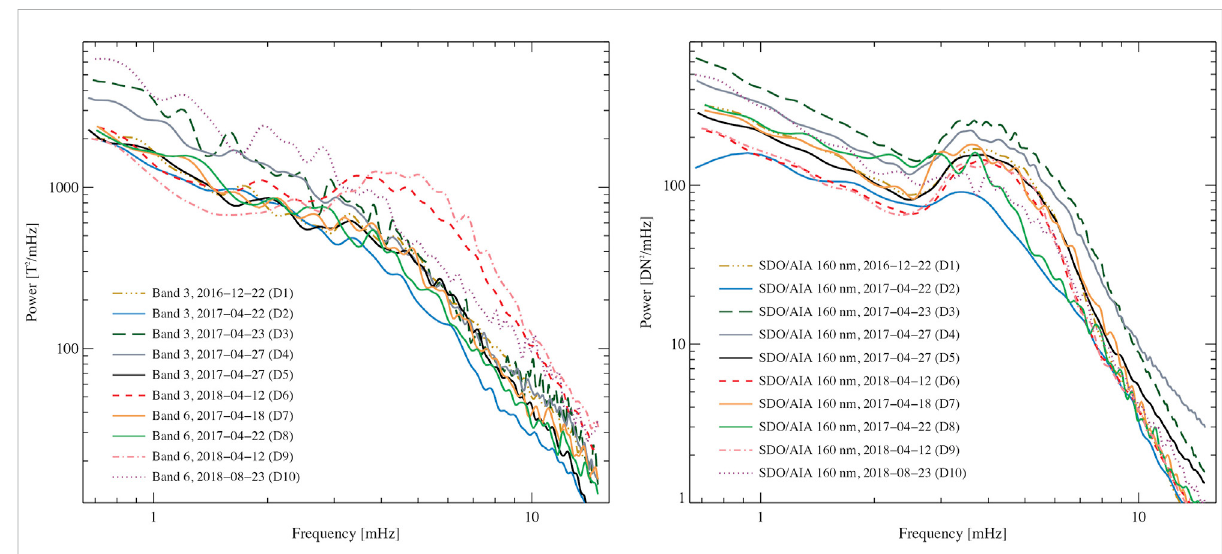
FIGURE 1 Mean power spectra from 10 ALMA datasets (averaged over the entire FOVs) observed in Band 3 and Band 6, sampling the mid-to-upper chromosphere (left) and from their lower chromospheric counterparts observed with SDO/AIA in 1600 Å (right). Images reproduced from Jafarzadeh et al.